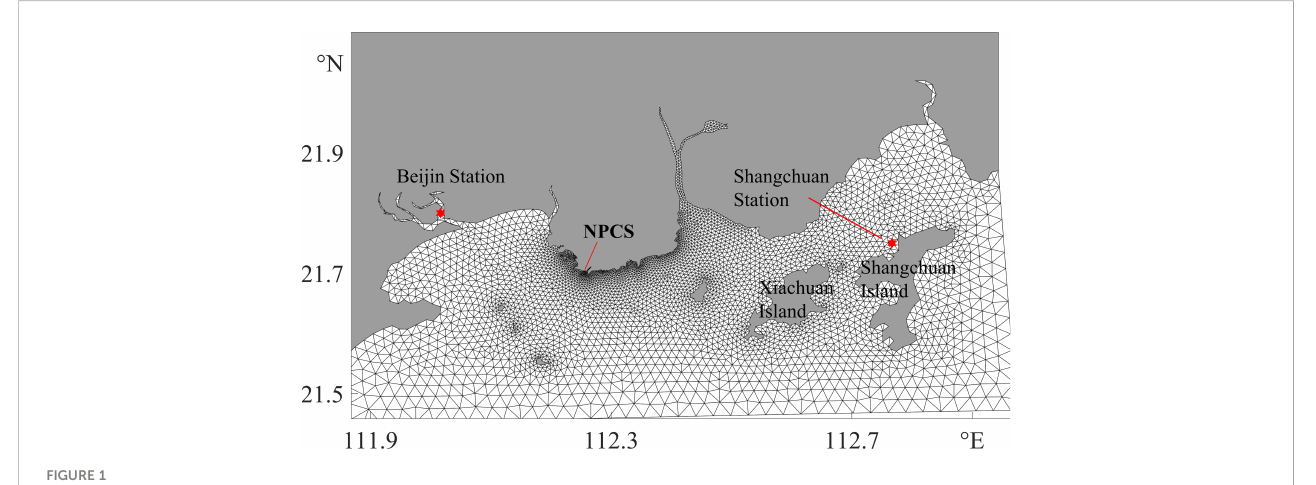
FIGURE 1 Model grid in the study area.